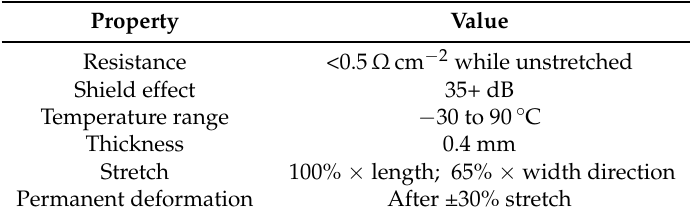
Table 2. Material